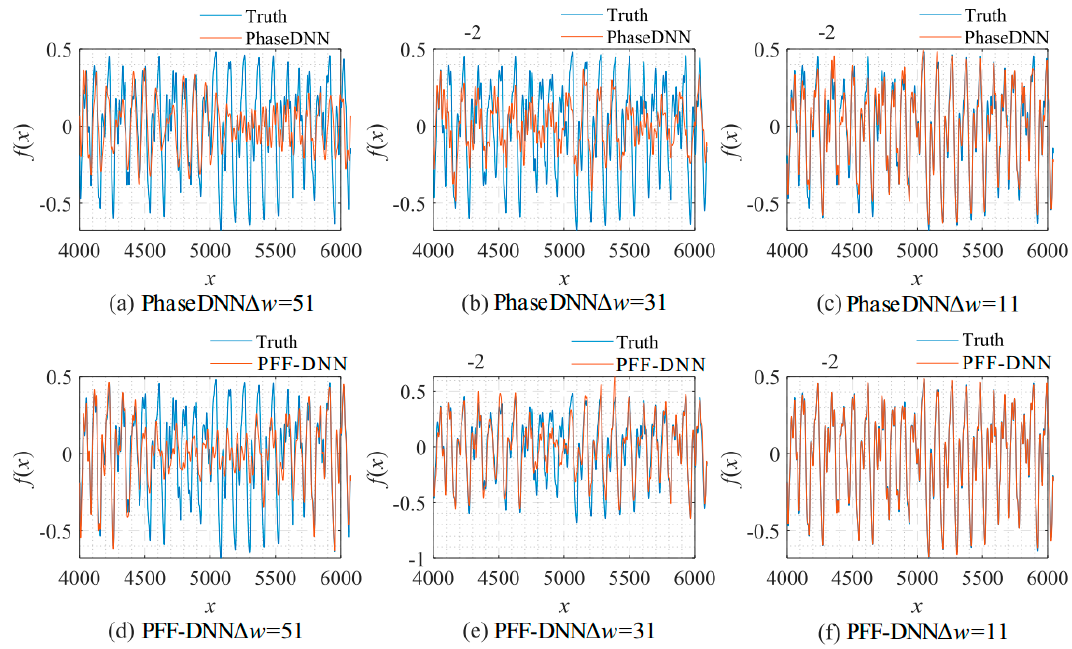
Figure 28. The influence of Δ ω on the algorithm performance. The fitting results of the PhaseDNN method after 10,000 updates: ( a ) Δ ω = 51; ( b ) Δ ω = 31; and ( c ) Δ ω = 11. The fitting results the of PFF-DNN method after 10,000 updates: ( d ) ∆ ω = 51; ( e ) ∆ ω = 31; and ( f ) ∆ ω = 11.